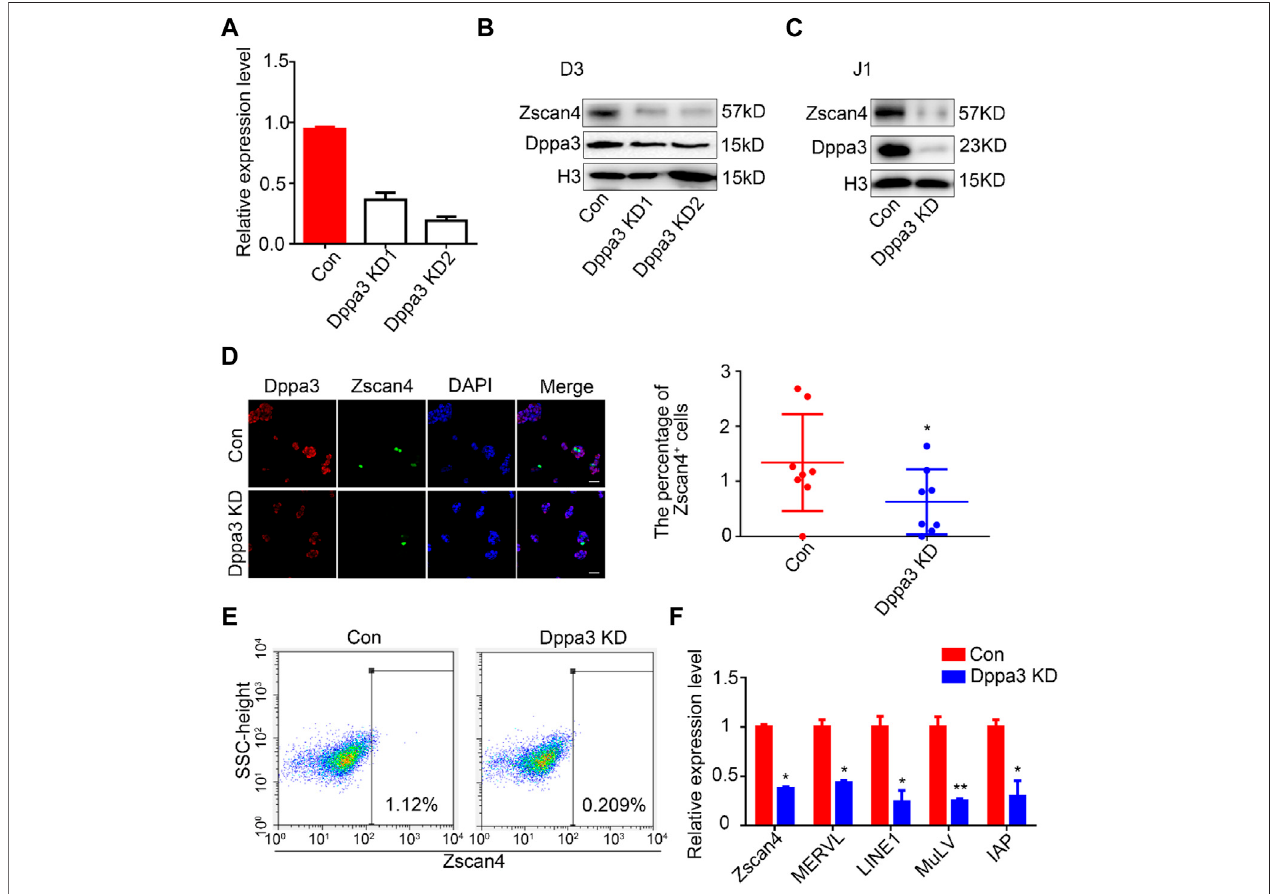
FIGURE2| Knockdownof Dppa3 impairthe2CLCsconversioninESCs. (A) Con fi rmationoftheexpressionlevelof Dppa3 intransient Dppa3 KDandcontrolESCs by quantitative PCR (n = 2, * p < 0.05). (B,C) The transient knockdown of Dppa3 decreases the Zscan4 protein level analyzed by western blot in D3 ESCs (B) and J1 ESCs (C) . (D) The transient Dppa3 KD reduces the Zscan4 positive cells by immuno fl uorescence staining of Zscan4 (green) and Dppa3 (red) in ESCs. Scale bar represents100 μ m.Right:ThenumberofZscan4positivecellswascounted( n =4;* p < 0.05;eachdotcorrespondstoonereplicateexperiment,inwhich200cells werecounted). (E) FACSpro fi lesofZscan4 + ESCsintransient Dppa3 KDESCs. (F) qRT-PCRanalysisofselected2C-speci fi cgenesandretroviralelements ’ expression in transient Dppa3 KD ESCs. Data are presented as mean ± SEM (n = 3, * p < 0.05; ** p < 0.01).